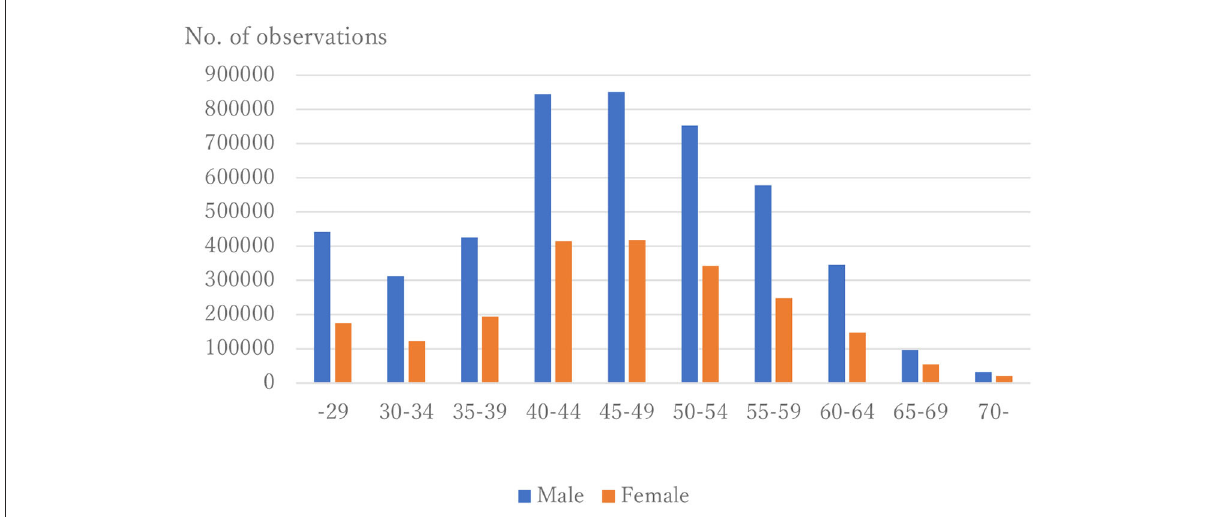
FIGURE1 Distribution of observations by age and